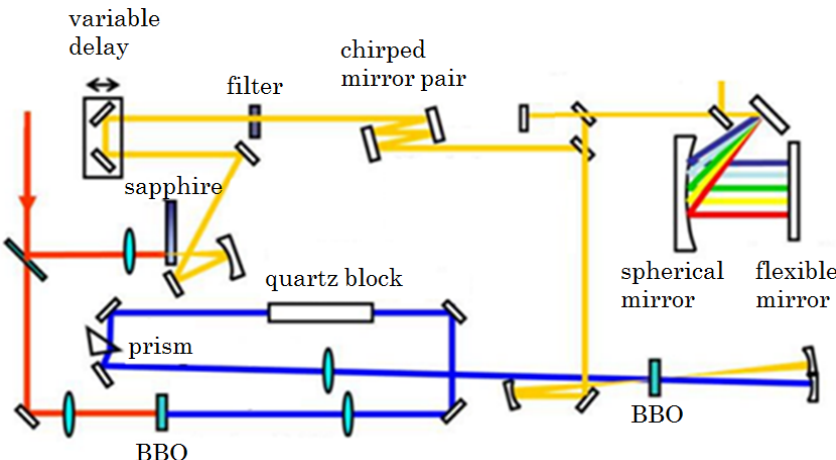
Figure 2. Schematic setup of non-collinear optical parametric amplification (NOPA). The filter is a short-pass cut-off filter which was used to block the fundamental light with wavelength of 800 nm. A quartz block was inserted to broaden time duration of the second harmonic pulse used as the NOPA pump. Red, blue, and yellow color lines represent the light with wavelengths of 800 nm, 400 nm, and visible broadband, respectively.